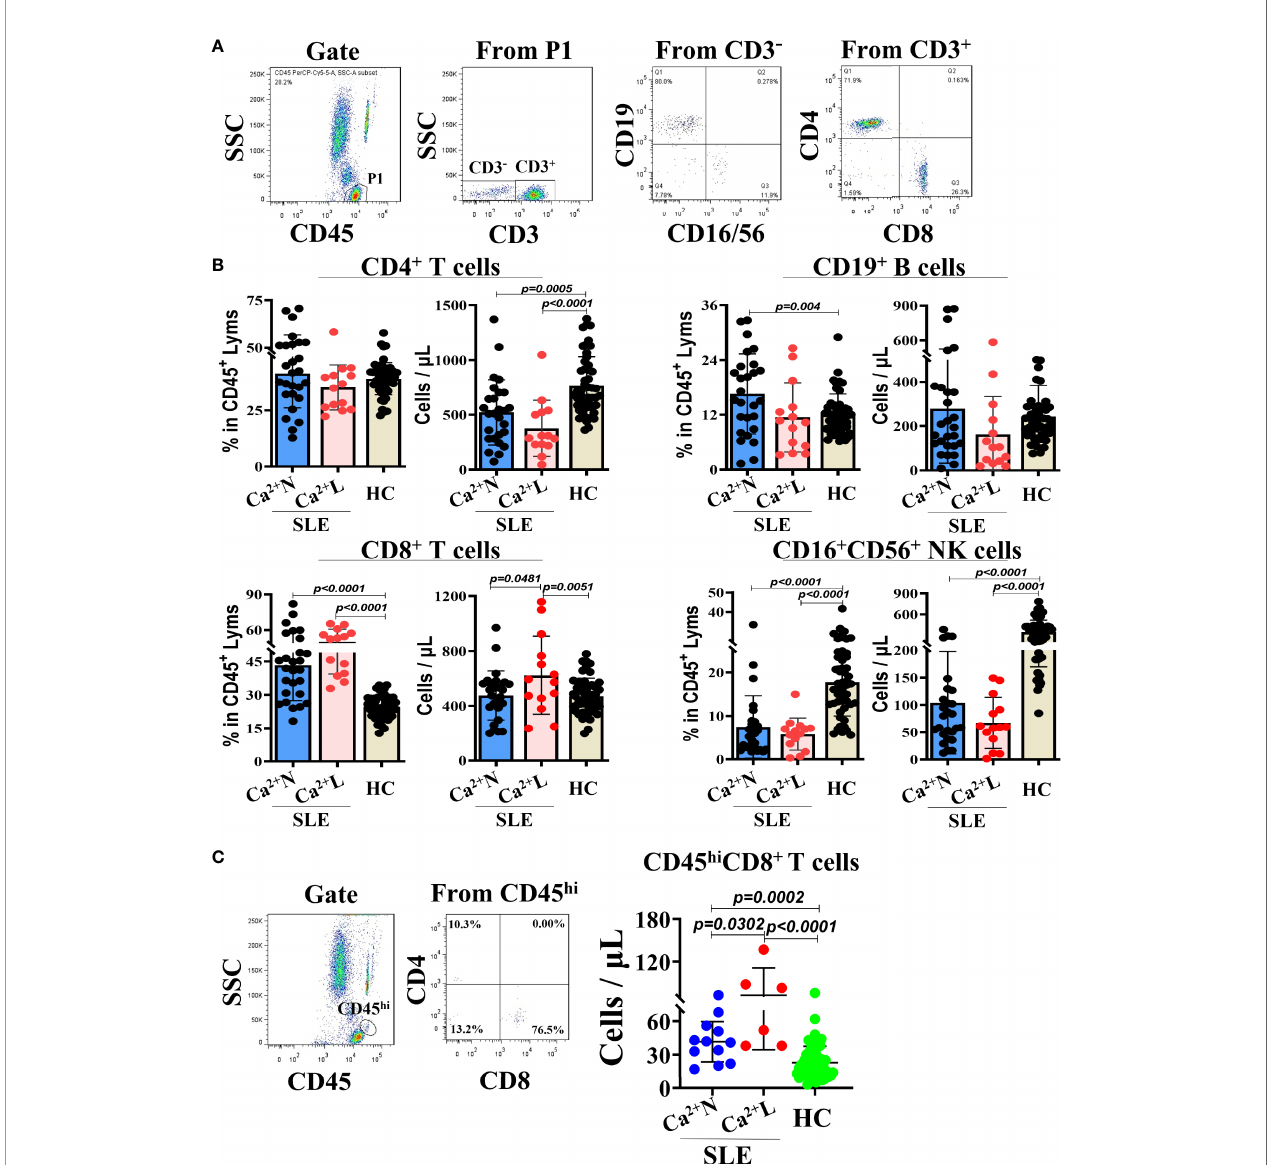
FIGURE 1 | TBNK lymphocyte subsets in peripheral blood of SLE patients with normal or low serum calcium levels and healthy people. The TBNK lymphocyte subsets in peripheral blood of SLE patients (n=41) and healthy people (n=50) were detected by fl ow cytometry and analyzed for their percentages and counts. (A) The gating strategy for analyzing the TBNK lymphocyte subsets. (B) The percentages and counts of TBNK lymphocyte subsets in CD45/SSC gated cells. (C) The numbers of CD8 + T cells in CD45 hi cells population of CD45/SSC gated cells. Each point in the scatter plot represents a person ’ s data, and the black line shows the mean